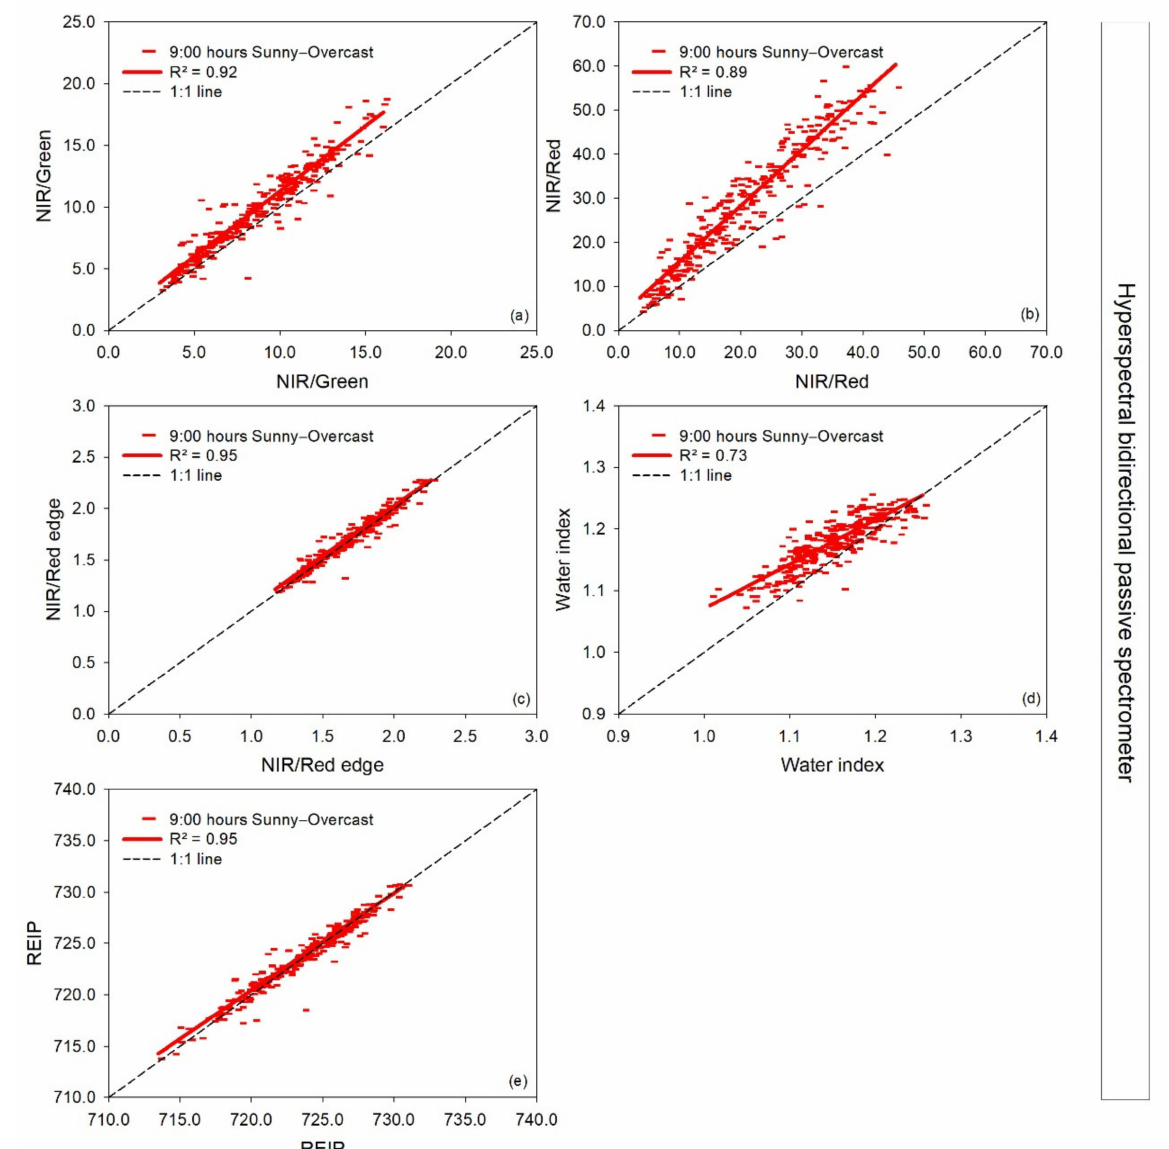
Figure 7. Linear regressions between paired measurement times at 9:00 h in a sunny (independent variable) (08-05-2019) and overcast (dependent variable) (07-05-2019) day of each vegetation index measured with the vehicle-carried hyperspectral bidirectional spectrometer. R 2 : coefficient of determination. The dashed line represents the 1:1 line. In the pairwise comparison, the sunny day’s information is indicated on the x-axis and for the overcast day on the y-axis ( a – e